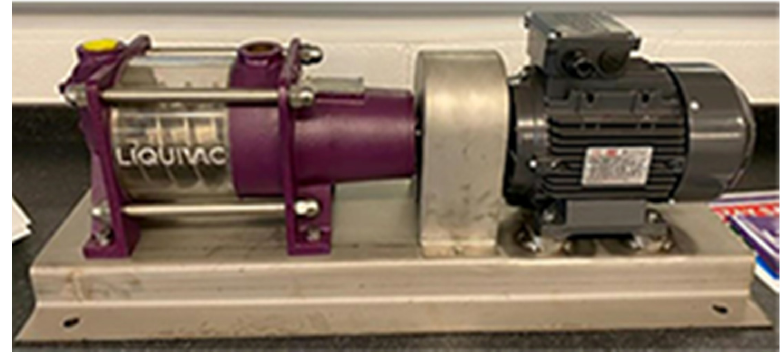
Figure 1. Transparent model of a Liquivac pump.